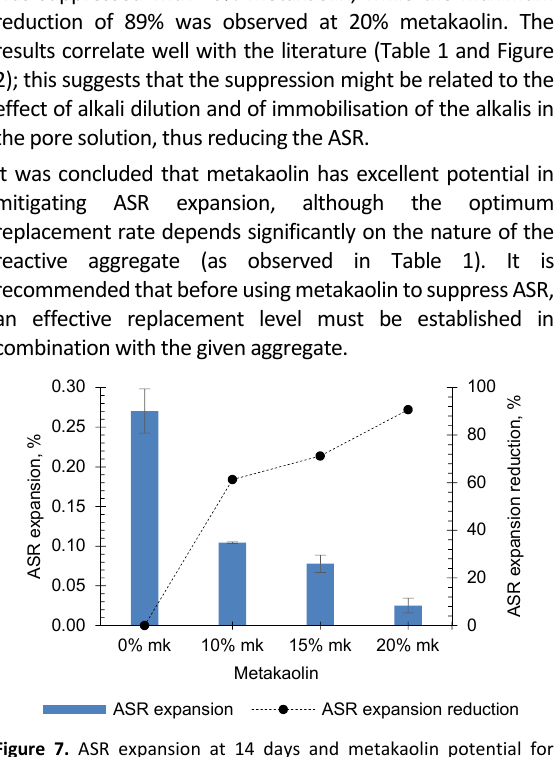
Figure 7. ASR expansion at 14 days and metakaolin potential for reduction expansion (ASTM C1567 ‐